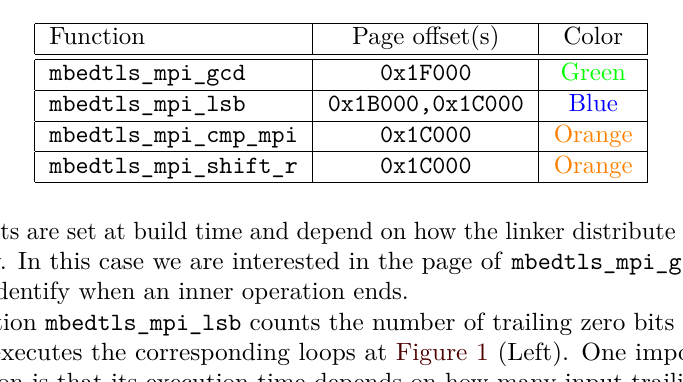
Table 2: mbedtls_mpi_gcd pages of